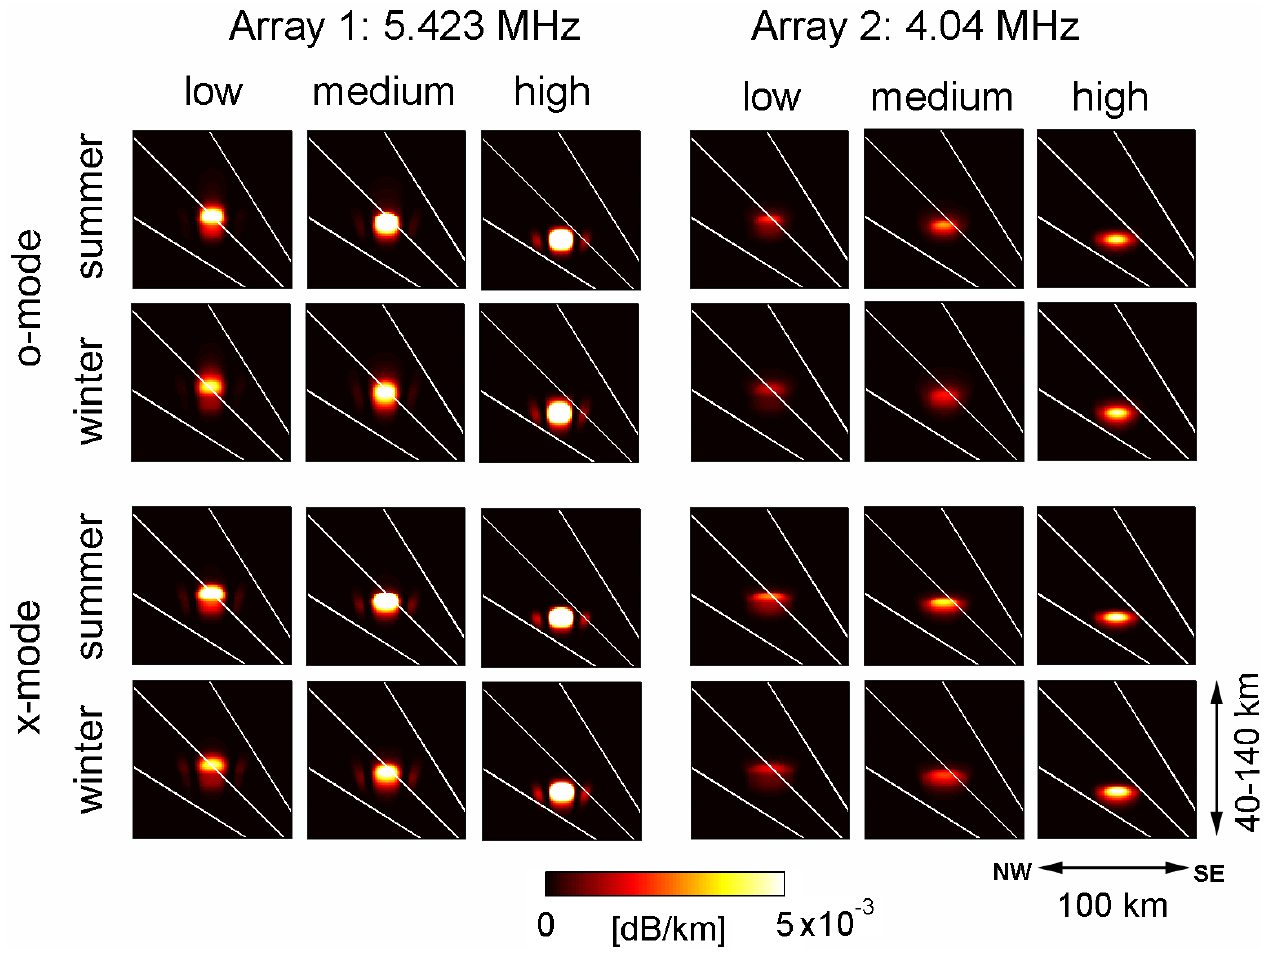
Fig. 3. Modelling of the increase in differential riometer absorption for 24 type cases of heating. The plots show vertical slices through the model volume in the NW-SE